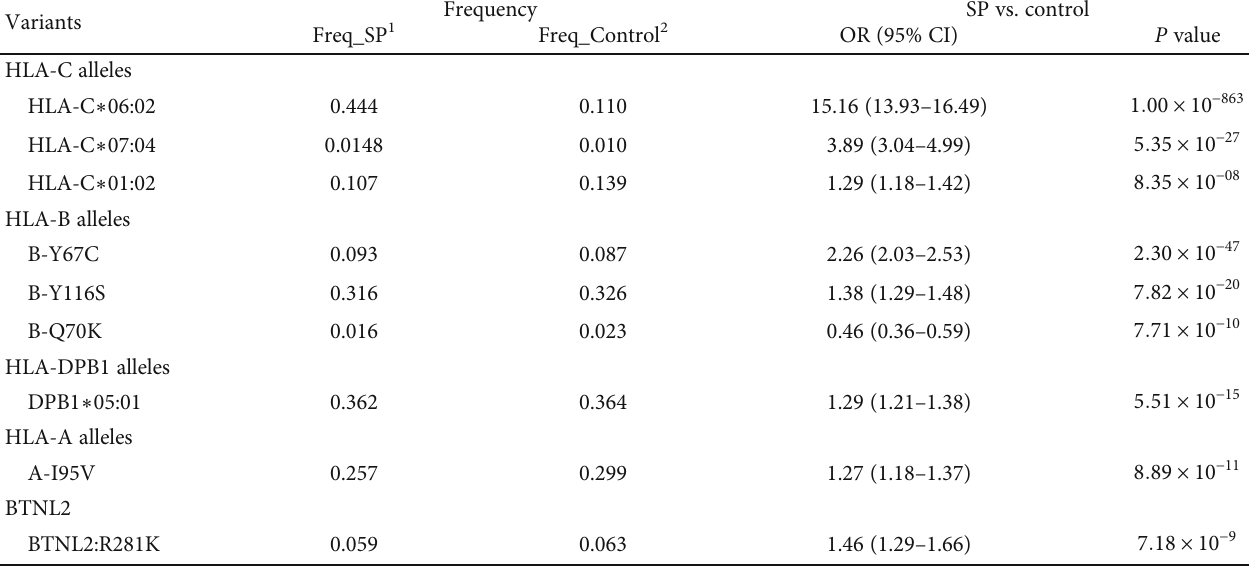
Table 3: Association of variants with sporadic psoriasis (SP) in the multivariate regression model.